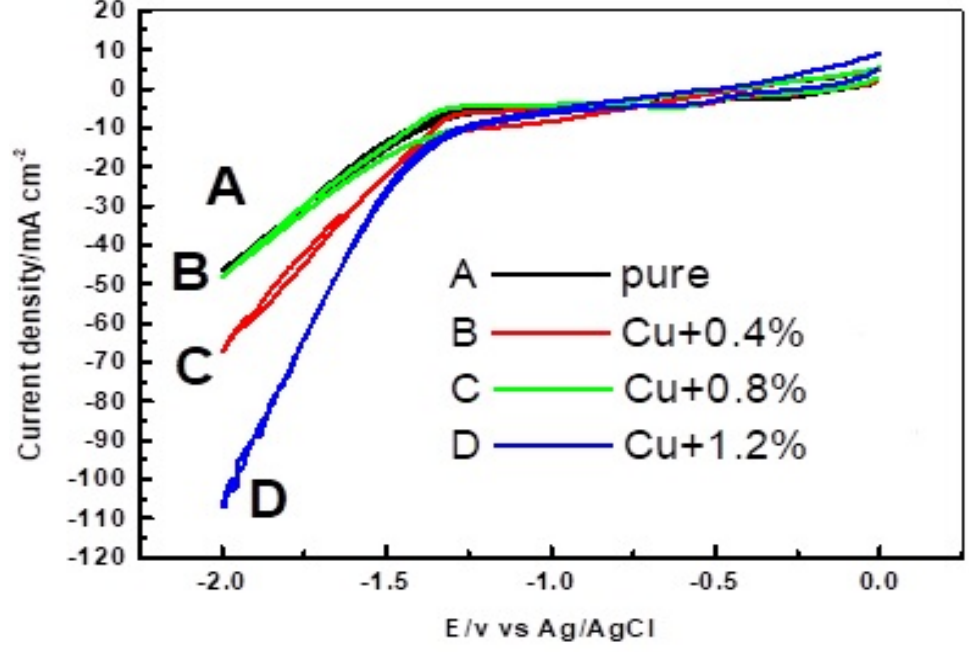
Figure 9. Cyclic voltammograms of Cu with different MWCNT contents.